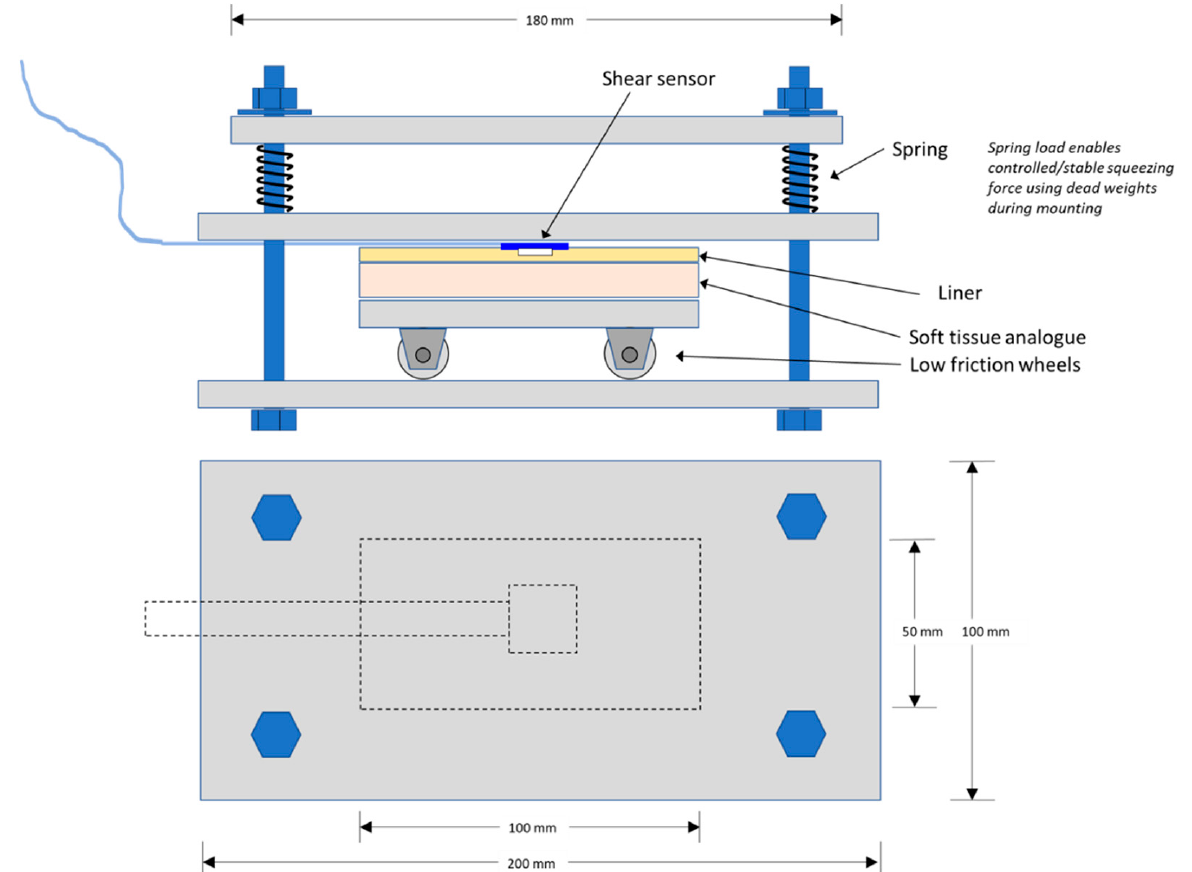
Figure 26. The design and arrangement of the shear sensor test rig.